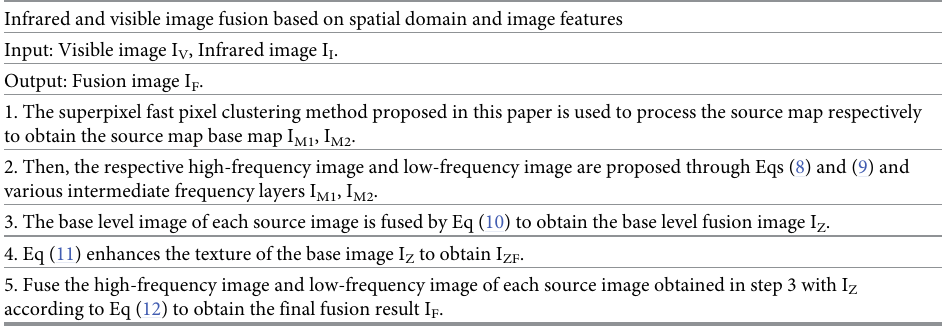
Table 1. The flow chart of the proposed algorithm. Infrared and visible image fusion based on spatial domain and image features Input: Visible image I V , Infrared image I I .